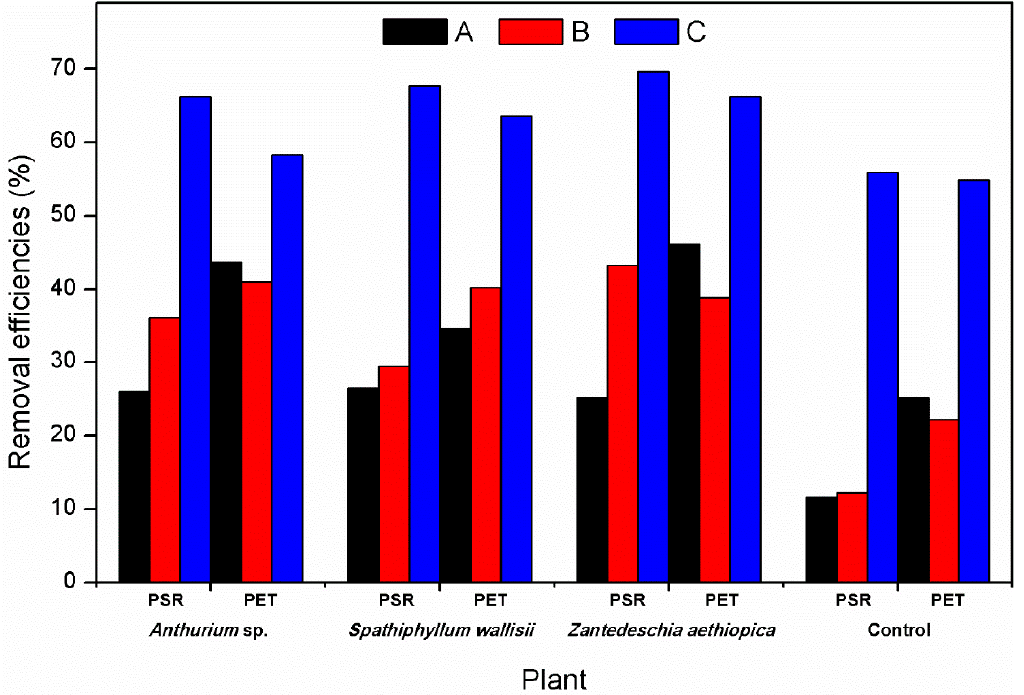
Figure 6. Pollutant removal of P-PO 4 (phosphates) ( A ), N-NO 3 (nitrates) ( B ), and BOD 5 (five-day biochemical oxygen demand) ( C ) in influent and effluent of microcosms.